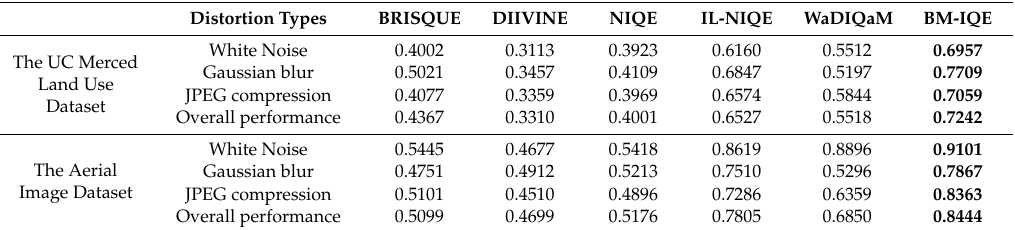
Table 5. Overall PLCC values of NR-IQA algorithms on remote sensing dataset.